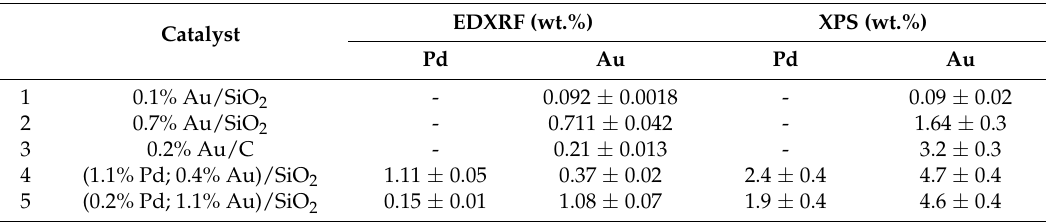
Table 1. The real values of Au loading in the resulting catalysts as confirmed by EDXRF and XPS analyses.